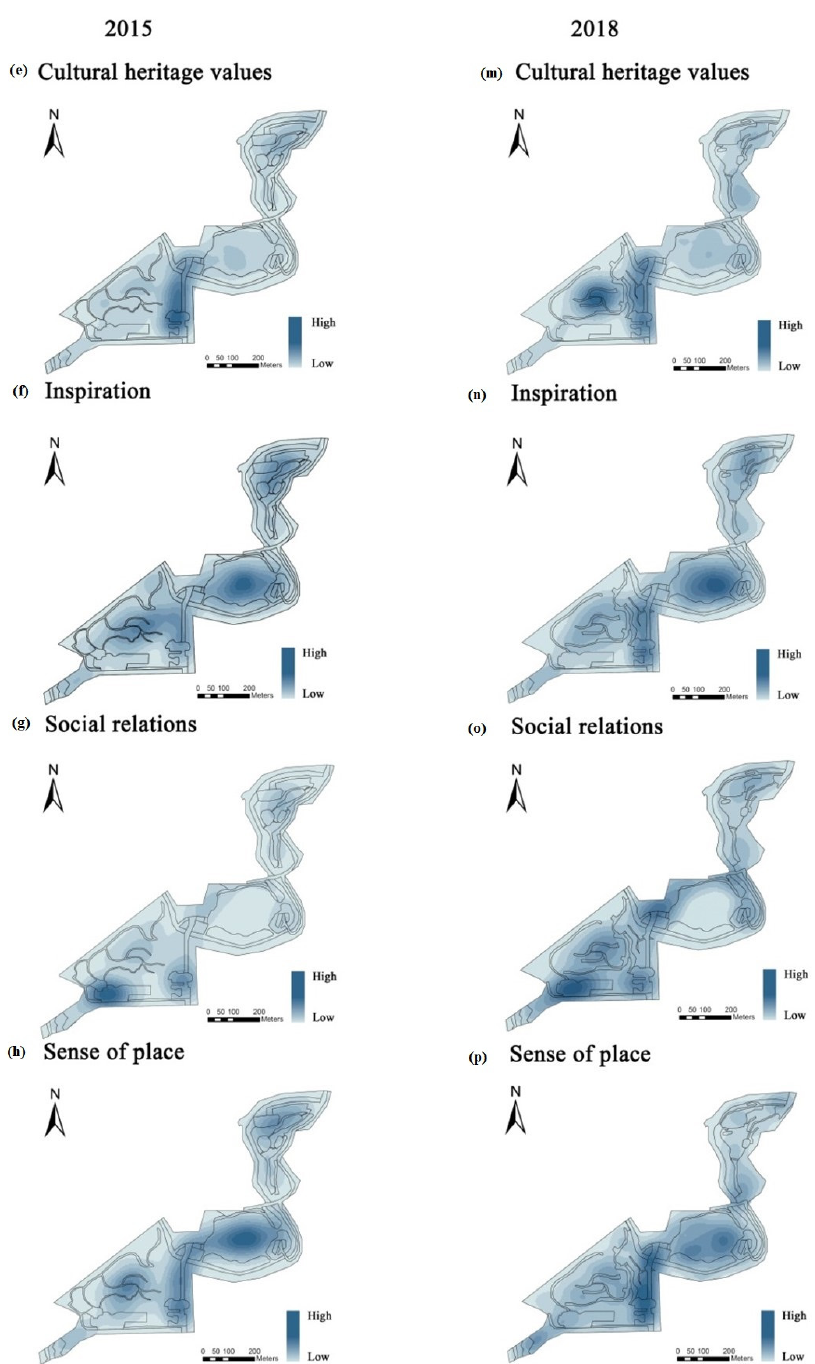
Figure 3. The distribution of each CES in 2015 ( a – h ) and 2018 ( i – p